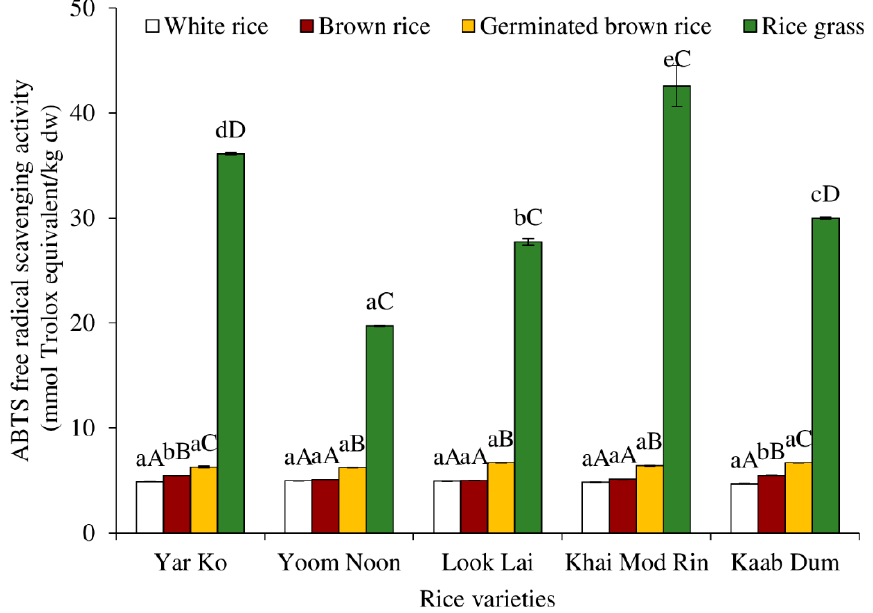
Figure 7. Effect of rice variety and processing condition on ABTS free radical scavenging activity of aqueous extract of Thai indigenous rice. Bars represent the standard deviations from triplicate determinations. Different lowercase letters within the same processing condition indicate significant differences ( p ˂ 0.05). Different uppercase letters within the same variety indicate significant differences ( p ˂ 0.05).